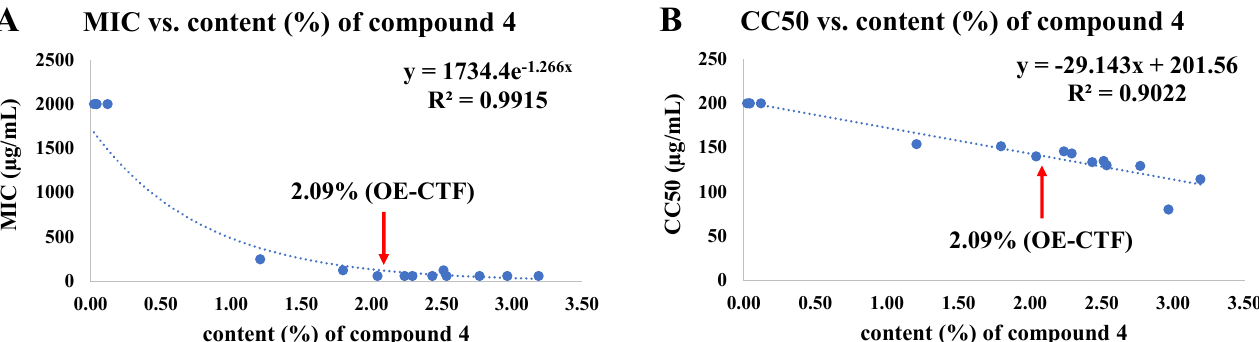
Figure 3. Correlations of content (%) of 6,8-diprenylgenistein ( 4 ) with antibacterial activity against S. iniae ( A ) and cytotoxicity on FHM cells ( B ) according to 15 extracts from BBD.